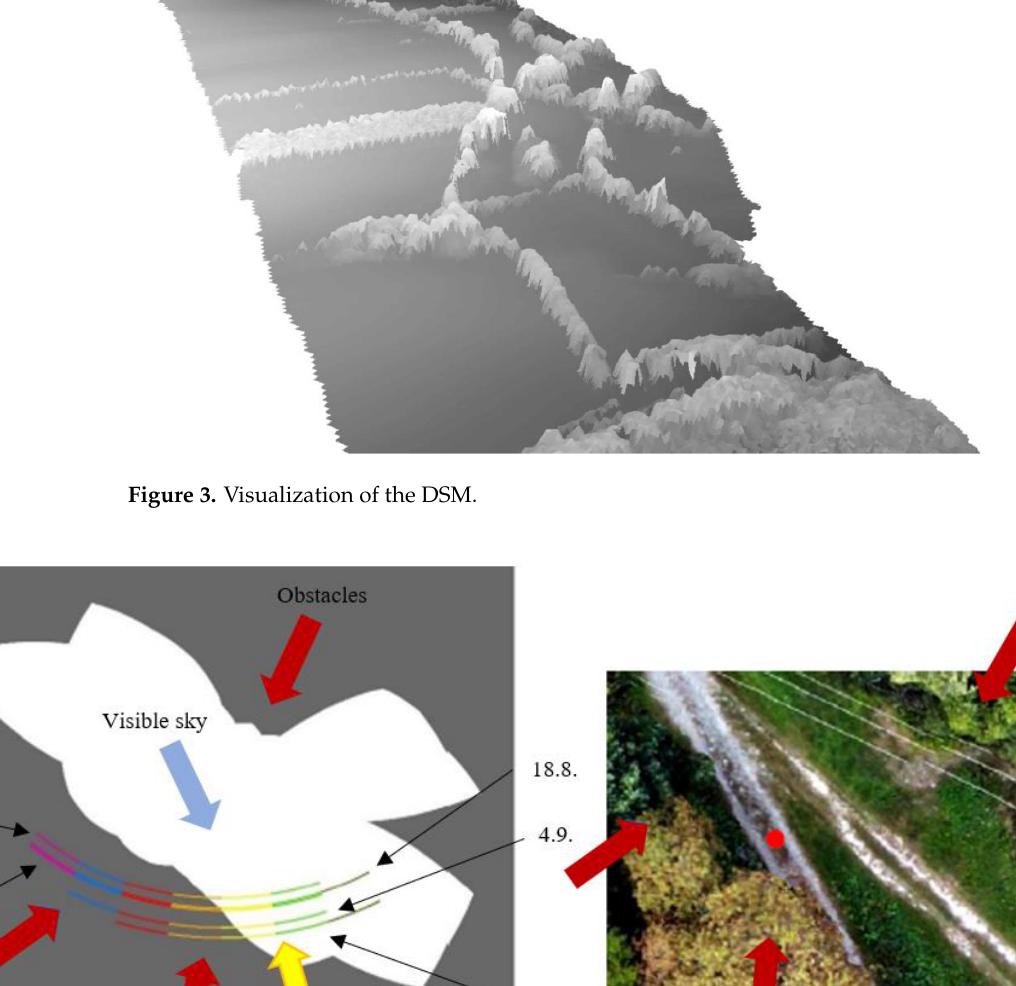
Figure 3. Visualization of the DSM.